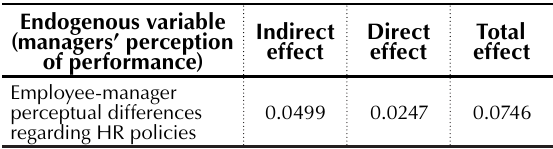
Table 7. Effects of mediator in the